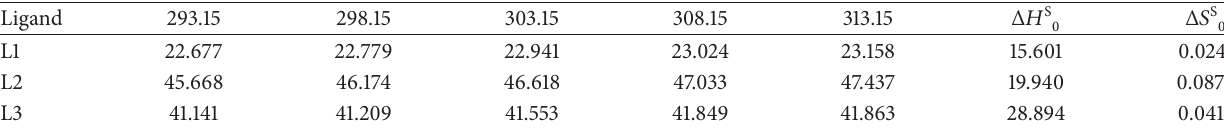
Table 10: The standard thermodynamic parameters of solvation (( Δ𝐺 S 0 and Δ𝐻 S 0 kJ mol −1 ) and ( Δ𝑆 S 0 kJ mol −1 ⋅ K −1 )) of L1, L2, and L3 at different temperatures ( 𝑇 /K).